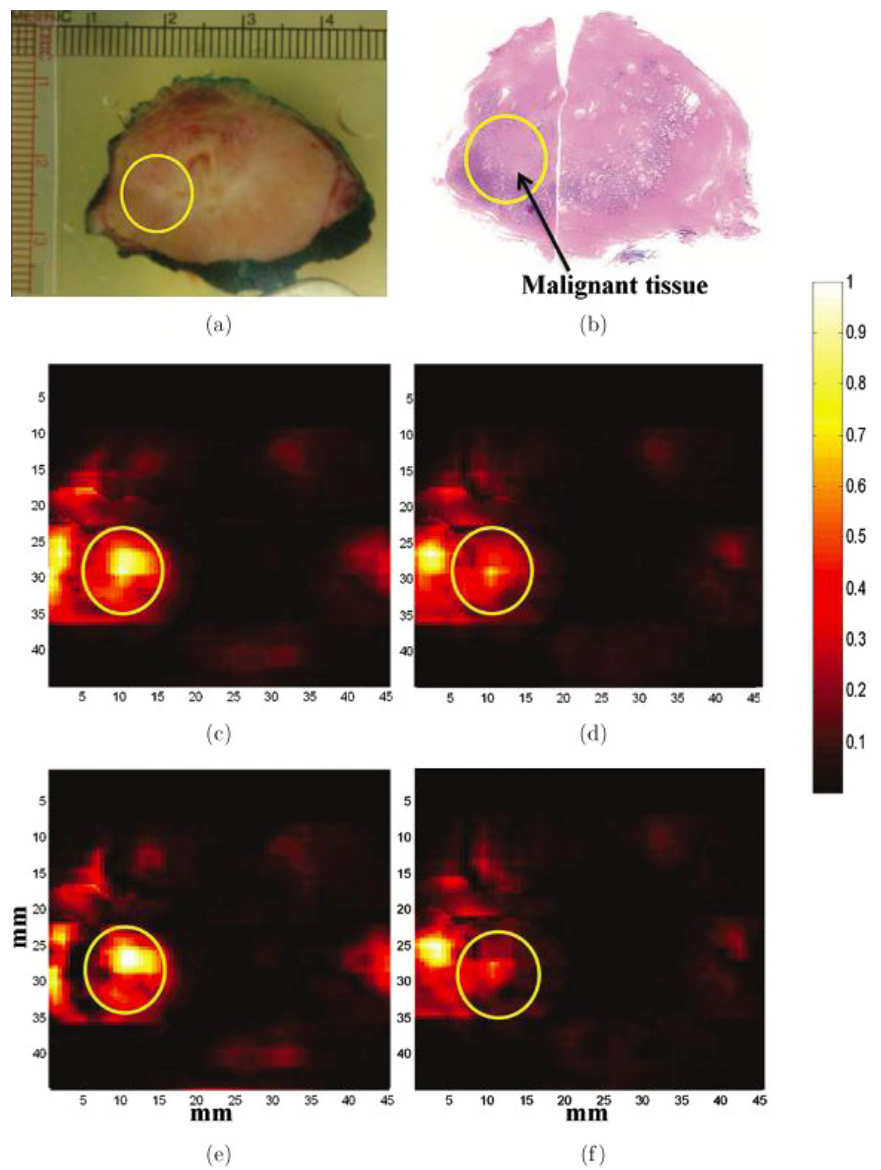
Fig. 5. Multispectral PA imgaes of a human prostate section. PA images are acquired at multiple laser wavelengths. Chromophore analysis was performed to extract PA images showing absorption of individual constituents from the multiwavelength images. (a) Photograph of imaged prostate specimen, (b) Histopathology slide of prostate with malignant region encircled, (c) Composite PA image acquired at 760 nm wavelength, (d) Composite PA image acquired at 850 nm wavelength, (e) Chromophore PA image showing the absorption of dHb, and (f) Chromophore PA image showing the absorption of HbO 2 . Higher absorption of dHb was seen in the region of interest corresponding to malignant prostate tissue compared to HbO 2